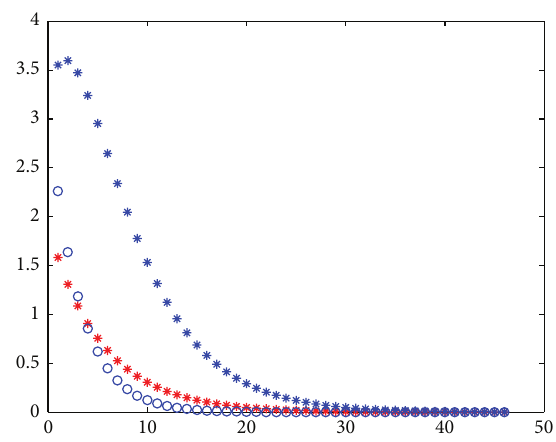
Figure 2: The errors of PSD and Jacobi iteration.